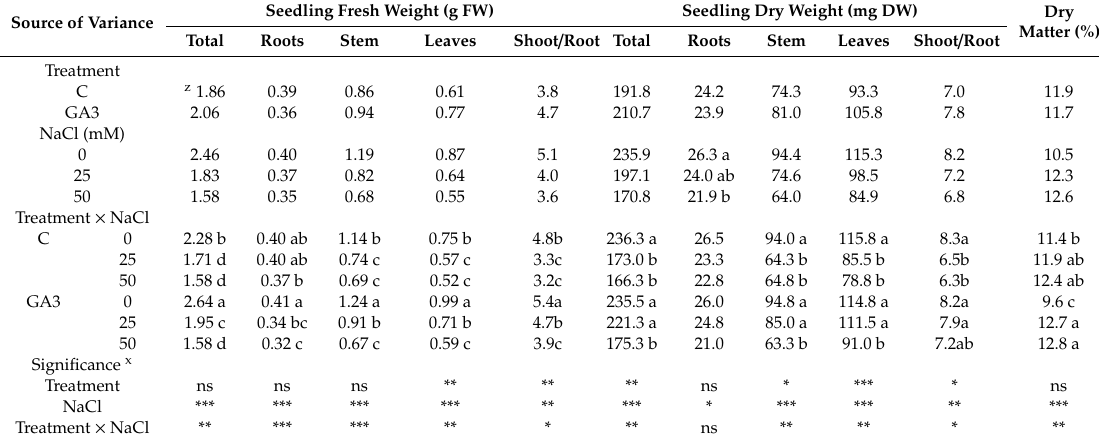
Table 1. E ff ects of gibberellic acid treatment (C, not treated; GA3, 10 − 5 M GA 3 ) and salt stress (0, 25, and 50 mM NaCl in the irrigation water) on morphological parameters of tomato seedlings. Source of